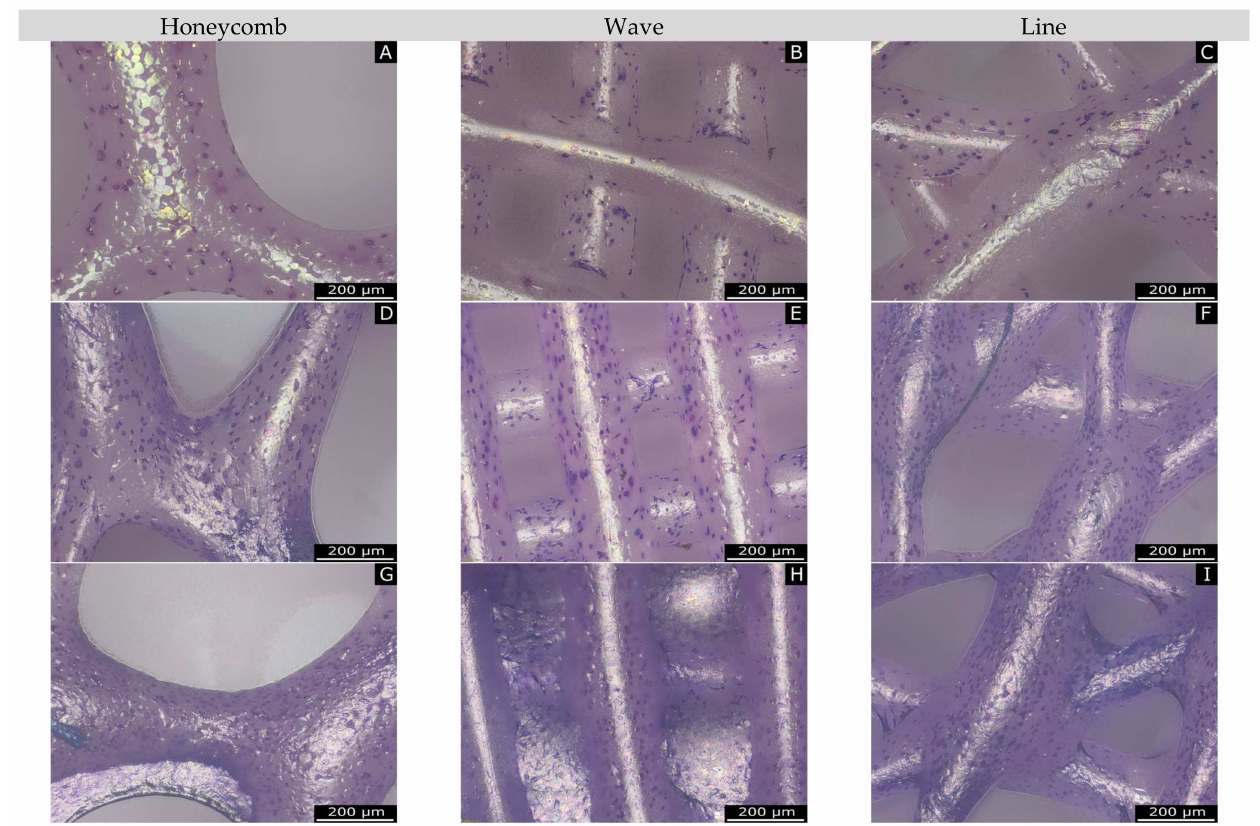
Figure 12. Overview of Giemsa staining. ( A – C ): day 3; ( D – F ): day 7; ( G – I ): day 10, for the different geometries.